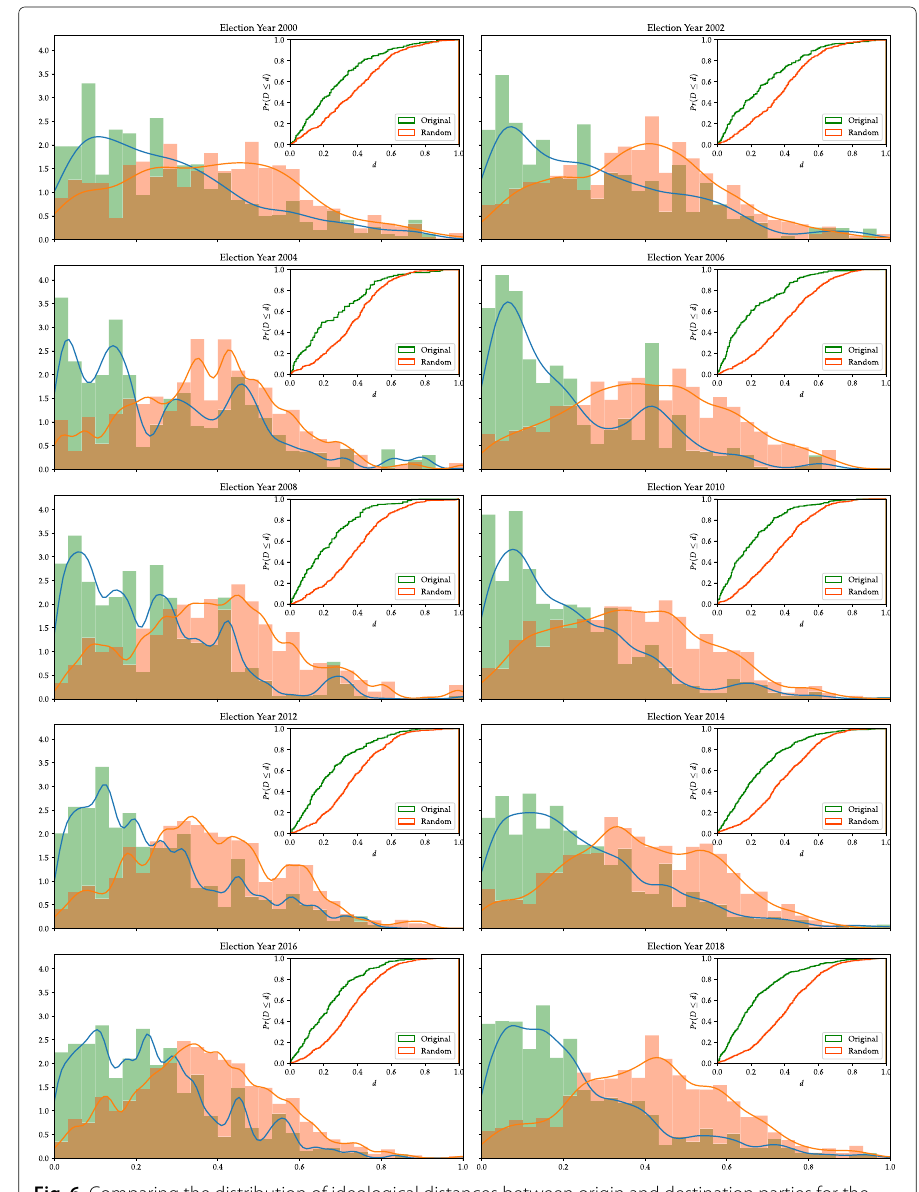
Fig. 6 Comparing the distribution of ideological distances between origin and destination parties for the empirical results and a configuration model as a theoretical baseline system. The main panels show the density distribution as histograms whereas the insets depict their corresponding cumulative distribution functions (CDF). When we compare the distance distribution between all origin and destination parties (green) with the baseline distances, should both endpoints of a party switch were picked at random (orange), we can see that, in general, the observed distances are significantly smaller than the ones from the randomized networks (See “Comparison with a configuration model” section for methodological details on our baseline model). Indeed, the model captures the structural phenomena of ideological proximity, as the switches tend to take place over shorter distance. Not surprisingly, the same trend had already been evidenced by community